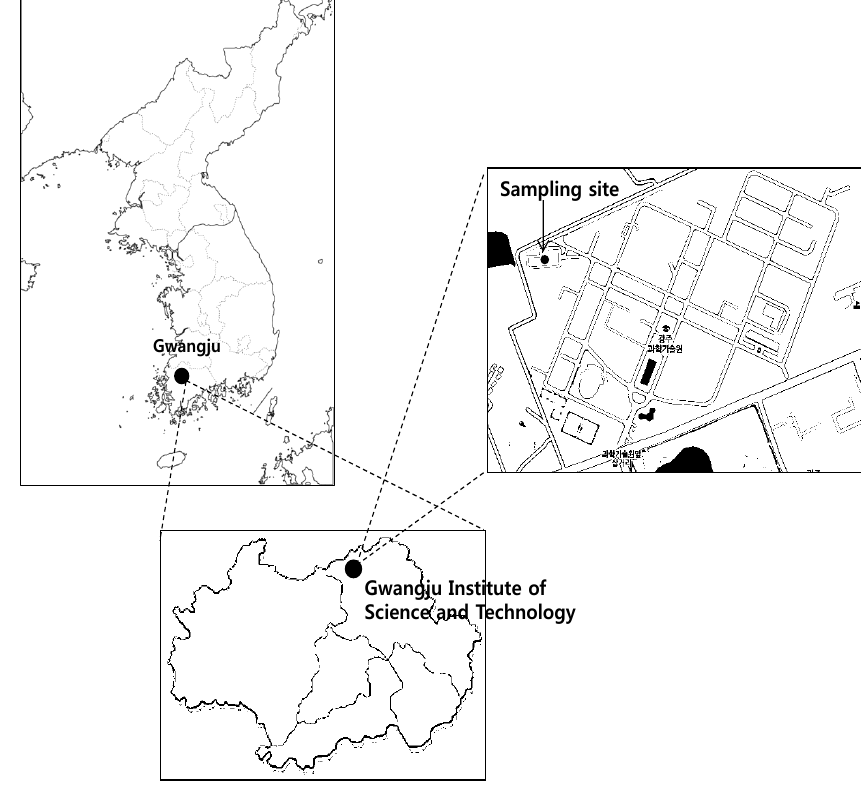
Figure 1. Location of the sampling site for this study.